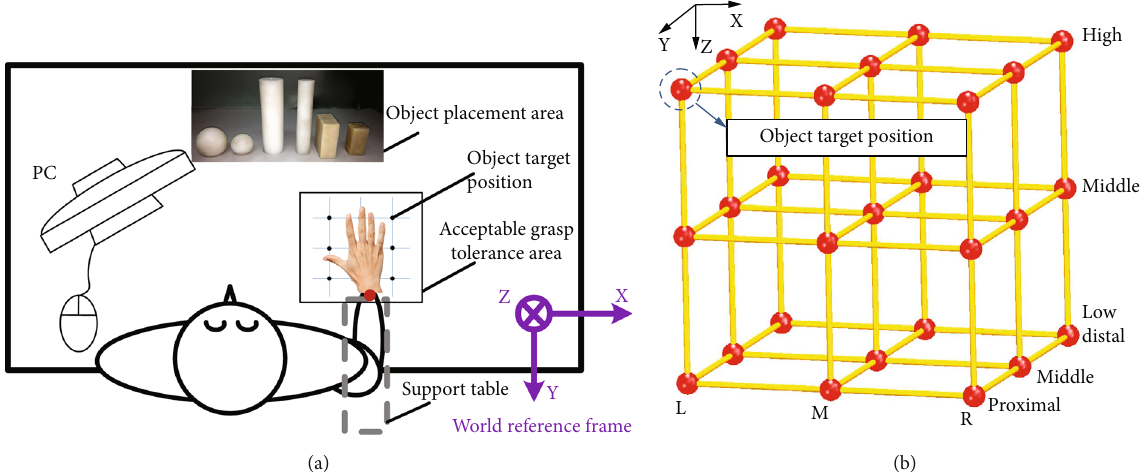
Figure 2: Experimentalsetup:(a) topview of the experimentalsetup;(b) 3Dview of27 relative positions( 3 X deviation × 3 Y deviation × 3 Z deviation ).